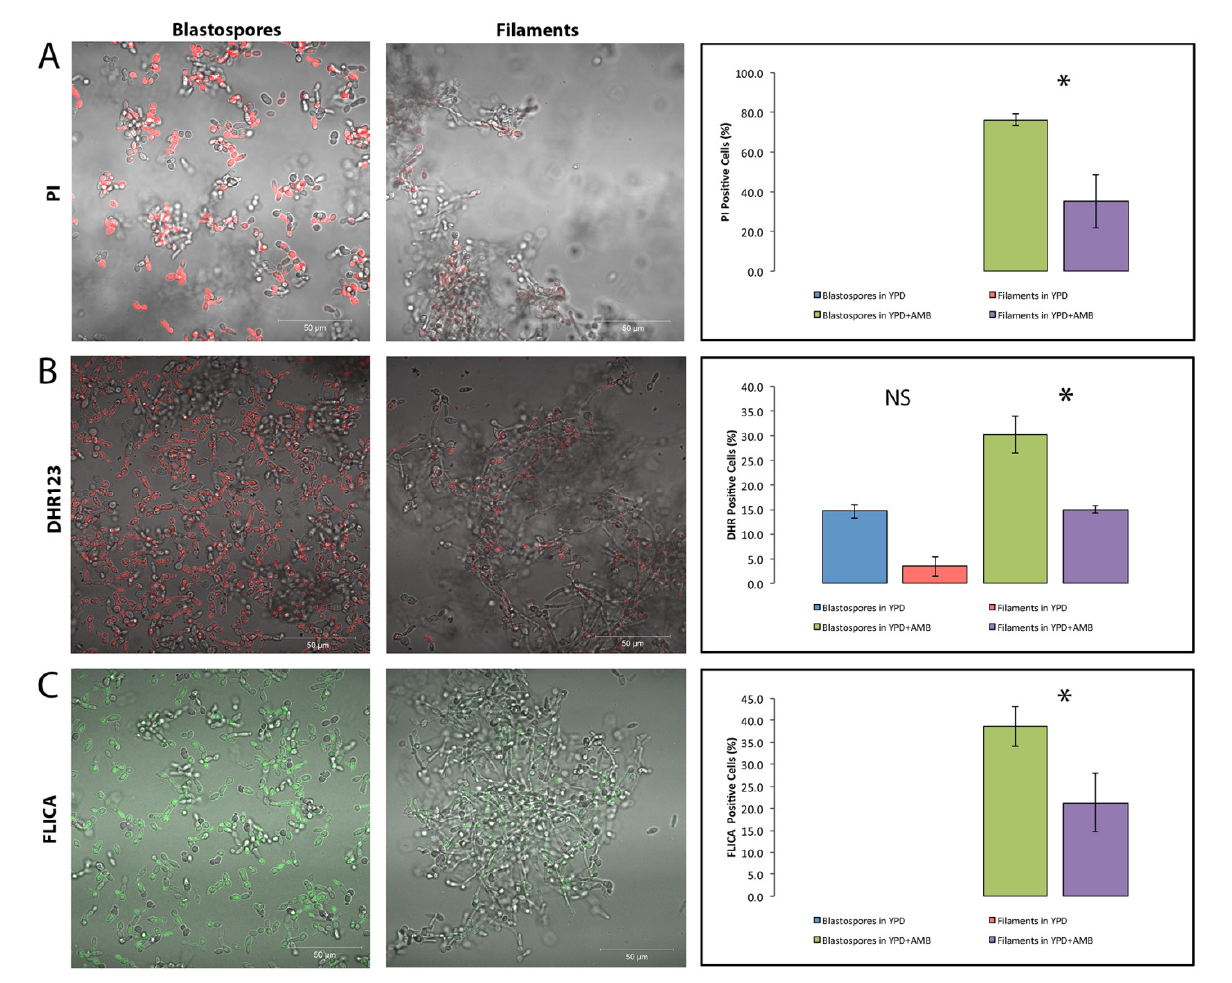
FIGURE 3: Filamentous C. albicans cells are more resistant than blastospores to caspofungin-induced programmed cell death. Representa- tive confocal scanning laser fluorescence images of wild-type SC5314 C. albicans cells treated with 0.05 μg/ml caspofungin for 3 hours in YPD. Propidium iodide stains dead cells, dihydrorhodamine 123 (DHR123) indicates the presence of reactive oxygen species (ROS), and the FLICA assay stains for cells with activated intracellular caspases. No PI or FLICA positive cells were observed in the no drug controls. Error bars indi- cate standard deviations for trials with at least three independent cultures, where at least 300 cells were counted for each trial. A single aster- isk indicates statistical significance (p < 0.05) as compared to treated controls. Statistical significance was determined with the unpaired Stu- dent’s